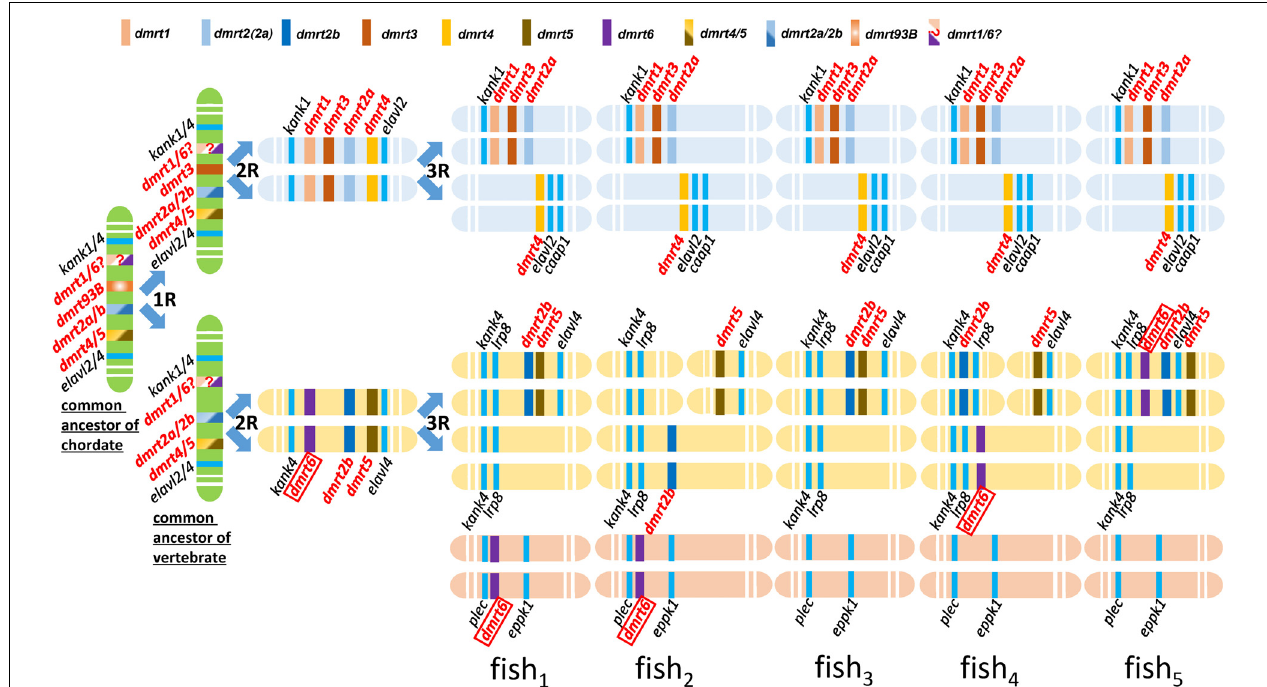
FIGURE 6 | Hypothetical evolutionary history of the dmrt genes in fish through fish-specific (3R) genome duplications. This figure was constructed based on figures in this study. The common ancestor of chordate might possess four ancestral genes, including dmrt4 / 5 , dmrt2a / 2b , dmrt93B , and dmrt1 / 6 . A common ancestor of vertebrata may have possessed four dmrt family genes, dmrt1 / 6 , dmrt2a / 2b , dmrt3 , and dmrt4 / 5 . The syntenies of kank1 - dmrt1 - dmrt3 - dmrt2a , dmrt4 - elavl2 - caap1 , kank4 - lrp8 - dmrt2b , and dmrt5 - elavl4 are conserved after three rounds of whole genome duplication in the ancestral vertebrates. dmrt6 is lost in most fish species.